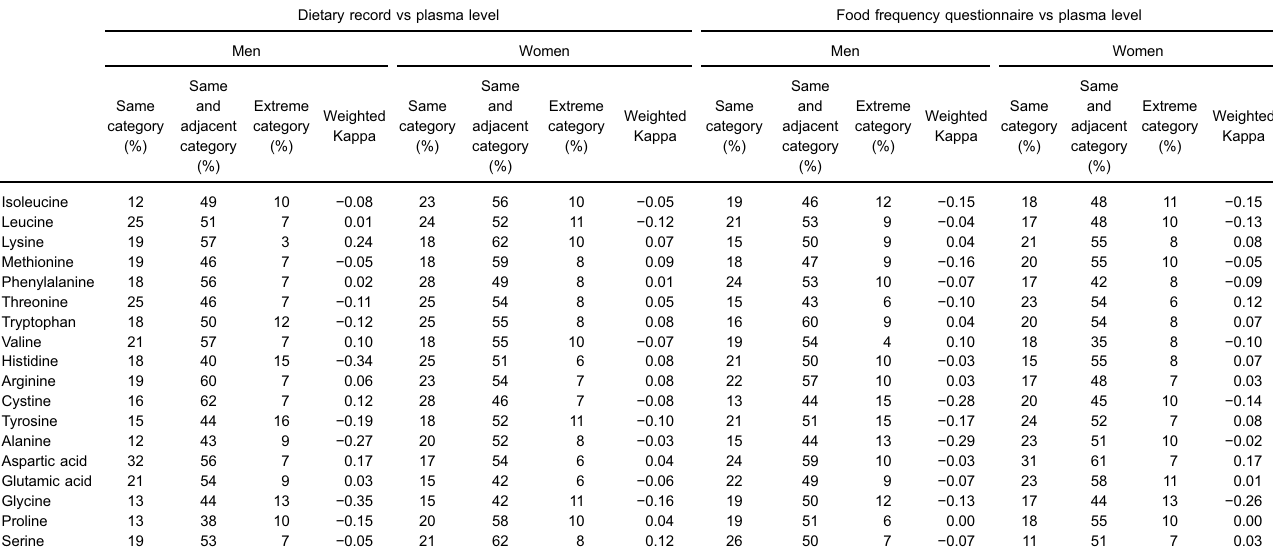
Table 7. Comparison of plasma amino acids with those from dietary records and a food frequency questionnaire based on joint classi fi cation by quintile Dietary record vs plasma